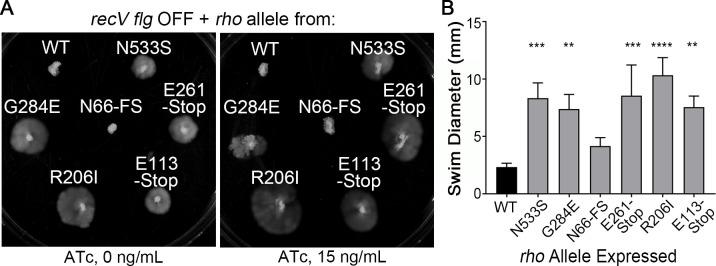
Mutant rho alleles confer dominant negative motility phenotypes.(A) Swimming motility in soft agar medium after 72 hours for the recV flg OFF (RT1693) expressing rho alleles encoding the indicated Rho proteins. Labels correspond to SNPs in rho (Fig 2A), and WT corresponds to the wild-type rho allele. Dominant negative effects are present regardless of anhydrotetracycline (ATc) induction suggesting leaky expression from the Ptet promoter. (B) Quantification of swim diameter from soft agar plates containing 15ng/mL ATc after 72 hours. The means and standard deviation of three biological replicates are shown. ****p<0.0001, ***p<0.001, **p<0.01 by one-way ANOVA and Dunnett’s post-test compared to recV flg OFF.